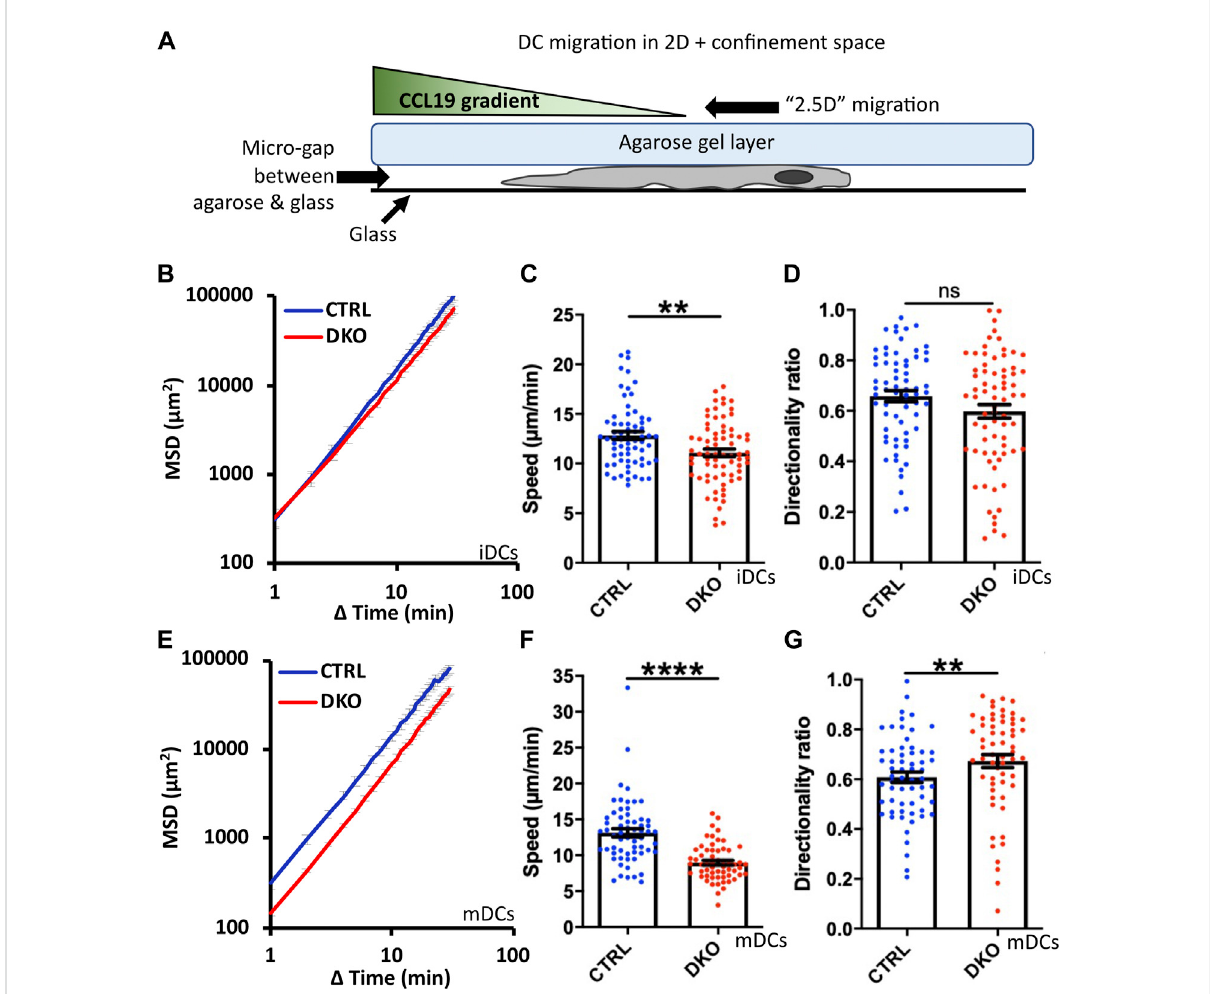
Loss of Evl and VASP impairs DC migration in con fi ned environments. (A) Illustration of experimental setup. Immature (B – D) or mature (E – G) control and DKO DCs were allowed to migrate under agarose for 6 h attracted by CCL19. Their migratory behavior was evaluated based on bright- fi eld images obtained at 1 min intervals. (B,E) Quanti fi cation of Mean Squared Displacement (MSD). Speed (C,F) and directionality (D,G) are depicted as mean ± SEM (N (iDC control) = 67, N (iDC DKO) = 72, N (mDC control) = 61, N (mDC DKO) = 59 cells from 3 independent